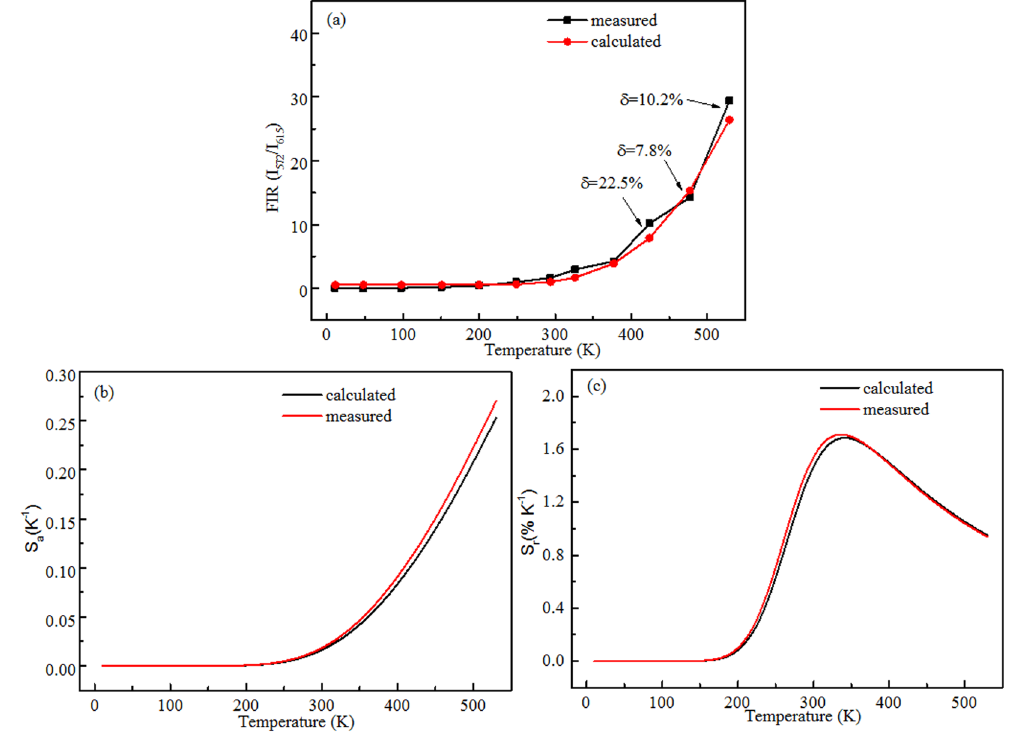
Figure 10. ( a ) Experimental measured and calculated plots of FIR (I 572 /I 615 ) versus temperature. ( b ) Measured and calculated absolute sensitivity S a and ( c ) relative sensitivity S r versus